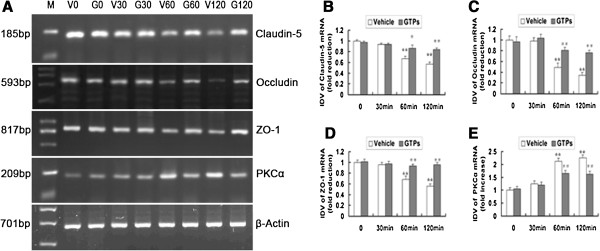
Effects of GTPs on the expression of claudin-5, occludin, ZO-1, and PKCα mRNA at the early stage of brain ischemia were determined by RT-PCR. (A) M, DNA ladder; V0–V120, 0, 30, 60, and 120 min after ischemia in the vehicle group; G0–G120, 0, 30, 60, and 120 min after ischemia in the GTPs-treated group. The mRNA levels of the gene expression were normalized to those of β-Actin as an endogenous reference. (B-E) IDV of claudin-5, occludin, ZO-1, and PKCα is expressed as a fold reduction or a fold increase relative to the vehicle group of ischemia 0 min. Data represent the means ± SD (n = 6, each). ** P < 0.01 vs. vehicle group of ischemia at 0 min. #P < 0.05, ##P < 0.01 vs. vehicle group at the same time points.